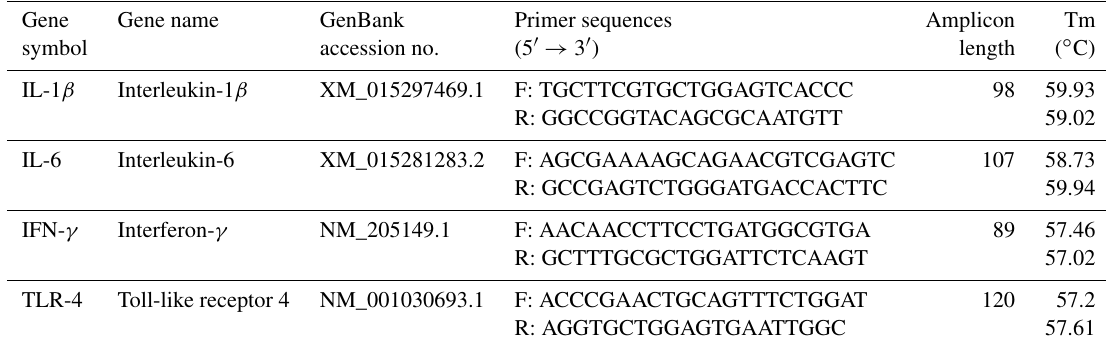
Table 2. Primer sequences of immune-related genes. Gene